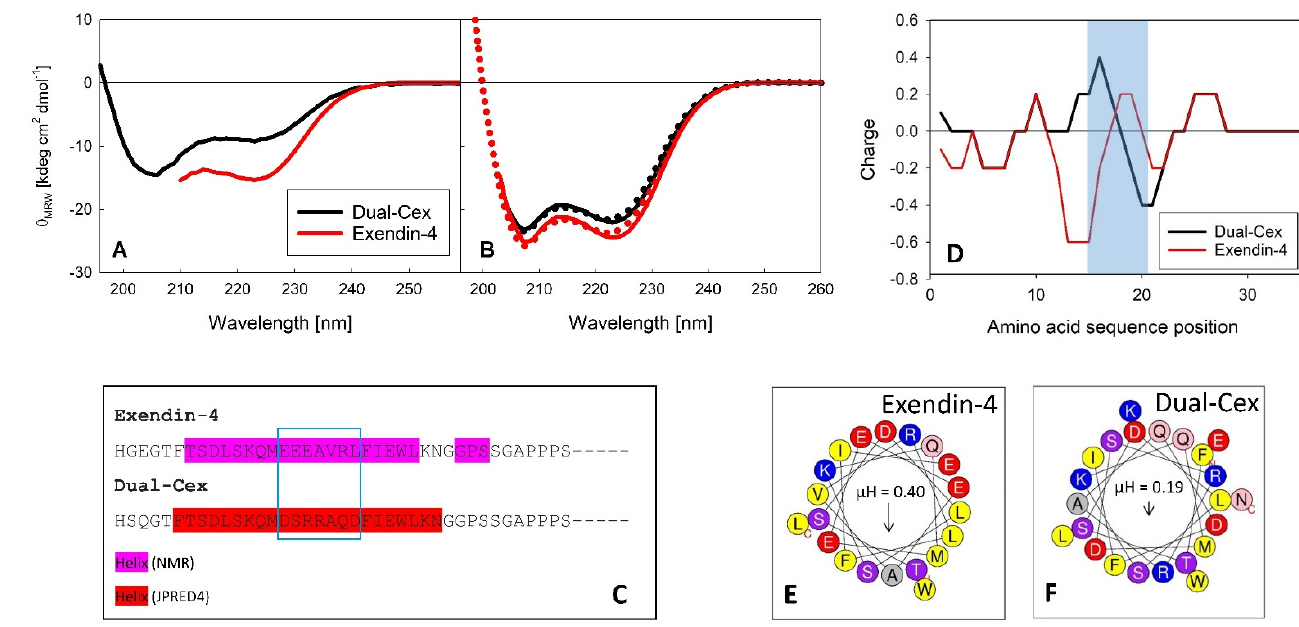
Figure 4. Secondary structure of exendin-4 and Dual-Cex. Far-UV CD spectra of exendin-4 and Dual-Cex were measured in PBS ( A ) and in 30% TFE ( B ) at pH 7.4 at concentrations < 0.1 mM which grant a monomeric state of all peptides. Amino acid sequence alignment of exendin-4 and Dual-Cex. ( C ) Amino acids in an α -helical conformation as derived from NMR experiments or predictions (JPRED4 [23]) are colored pink and red, respectively. A charge plot of exendin-4 and Dual-Cex calculated with the Emboss charge tool [24], using a sliding window of five, is shown in ( D ). The blue frames in ( C ) and ( D ) indicate the main difference between both peptides originating from the sequence stretch engineered into the exendin-4 backbone from oxyntomodulin in Dual-Cex. Helical wheel projections of exendin-4 ( E ) and Dual-Cex ( F ) using amino acids 6–28 comprising the central helical part of both peptides were calculated with HeliQuest [25]. Hydrophobic moments (µH) are indicated.